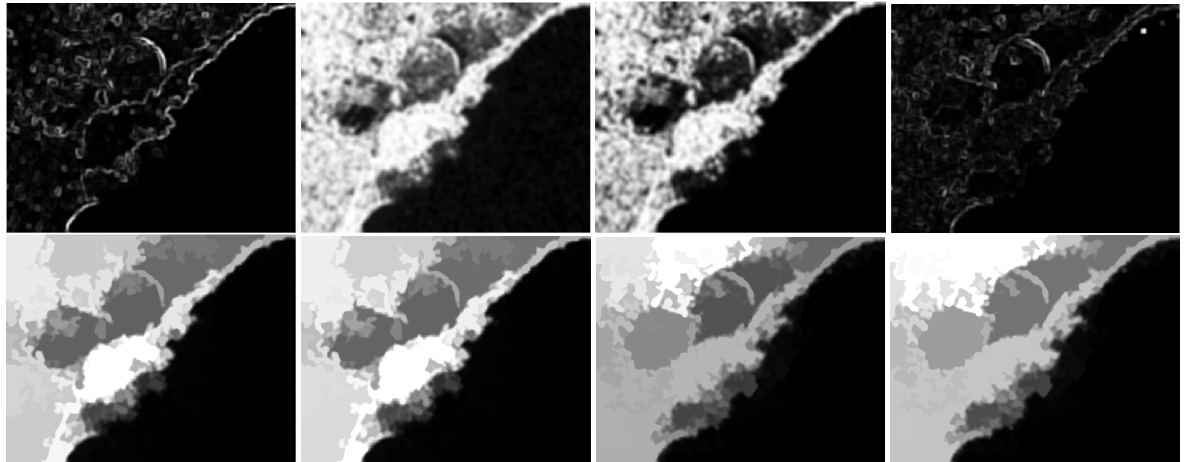
Figure 8: Illustration of Haralick textural features (top line) produced by GLCM method and multilevel AP features (bottom